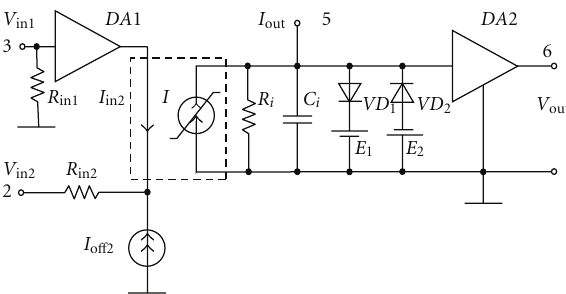
Figure 1: Nonlinear equivalent circuit CFOA of AD 844 type.